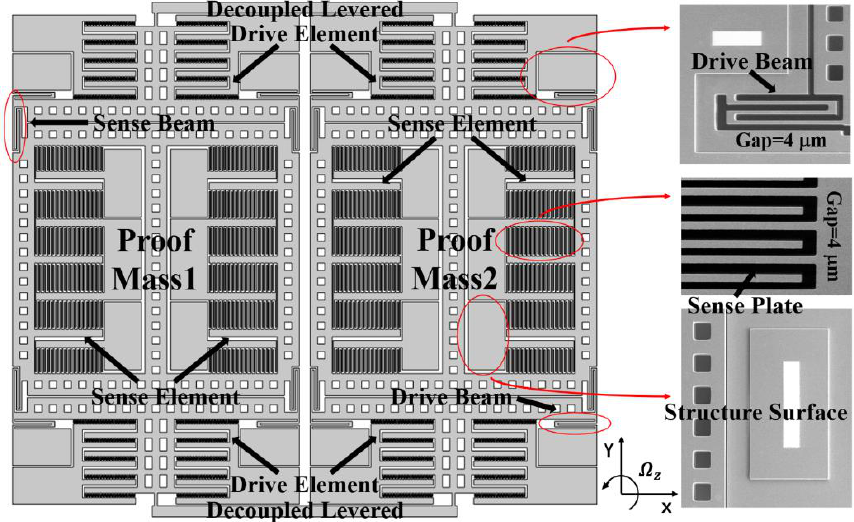
Figure 1. Typical schematic and SEM images of the as-fabricated dual-mass TFGs.